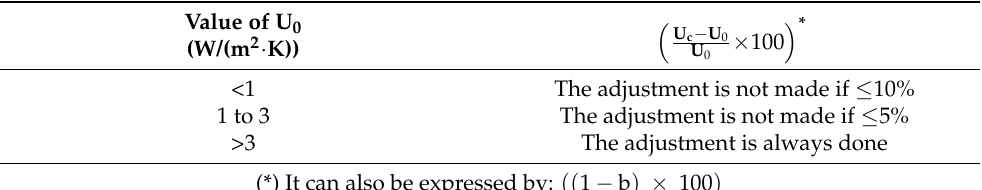
Table 2. Application of the adjusted U value (adapted from [10]).